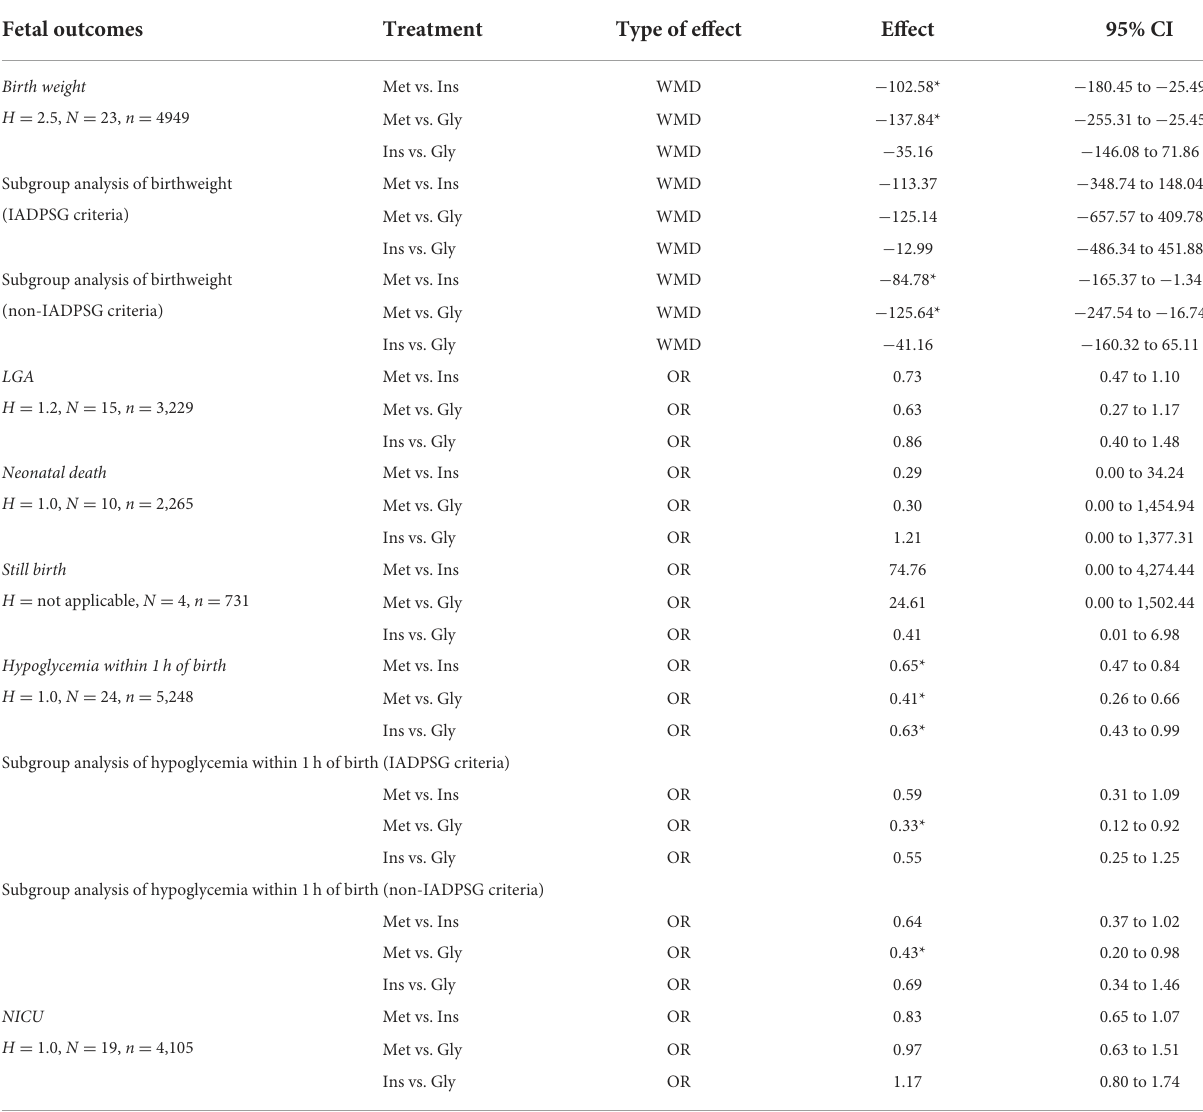
TABLE 3 The Bayesian network-analysis for fetal